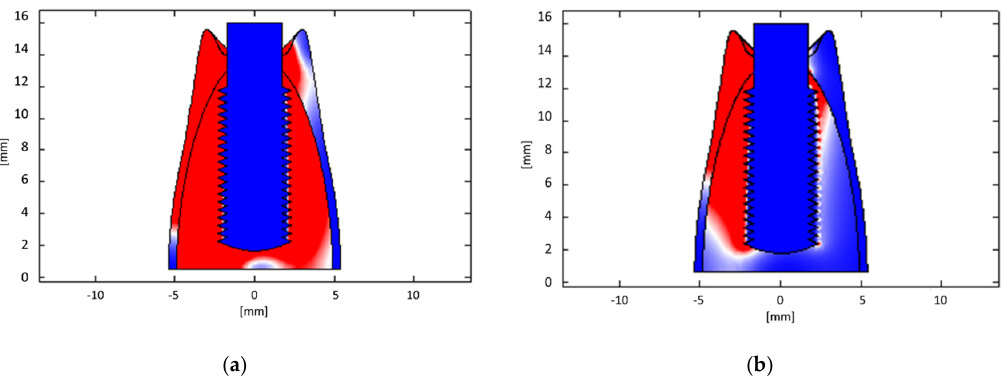
Figure 9. Regions above (red) and below (blue) ICNIRP limits for SAR value (2 W / kg) for ( a ) a maximum intensity therapeutic signal and ( b ) a reduced one (25%).